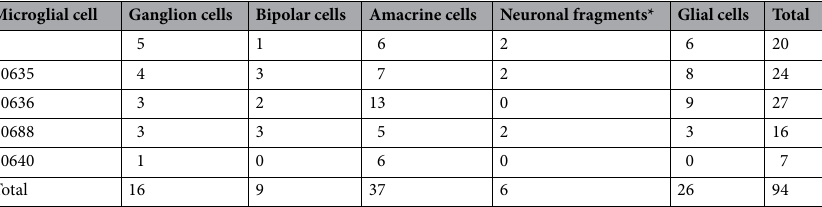
Table 1. Trogocytosis of macaque retinal neurons and Müller glial cells by microglia. The types of neurons and the Müller glial cells undergoing trogocytosis by each microglial cell are listed. In some instances, the neurons could not be reconstructed sufficiently to identify them with confidence, and these are called fragments.